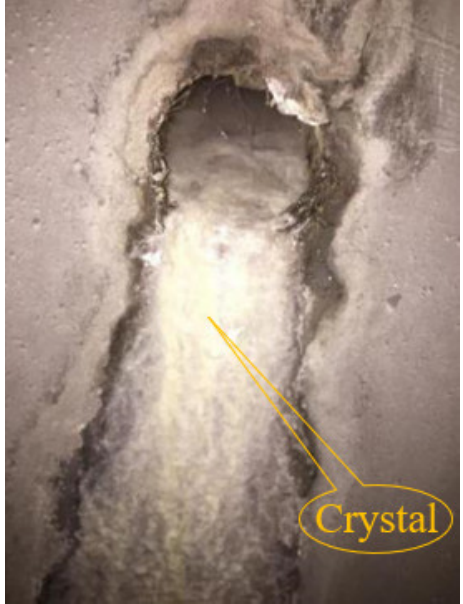
Figure 2. Crystal blockage of drainage pipe of Chongqing Metro Tunnel.